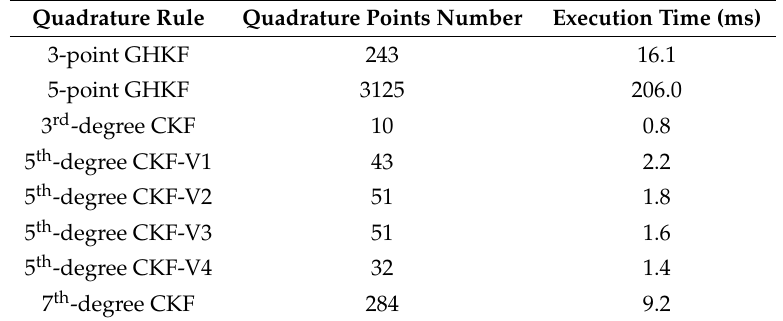
Table 2. Execution time per iteration for different quadrature rules used in this paper.